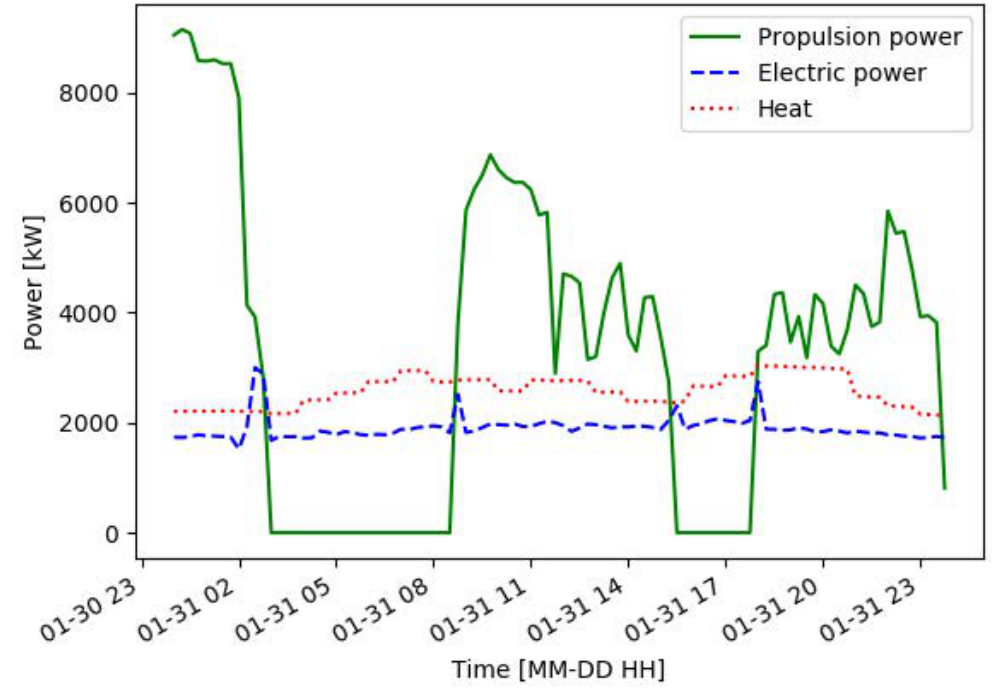
Figure 11. Energy demand during a day of operations, Winter (31 January).